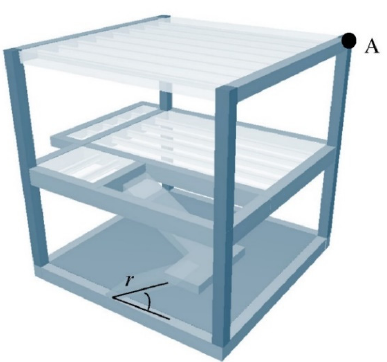
Figure 9. Model sketch II. Figure 10. Model sketch